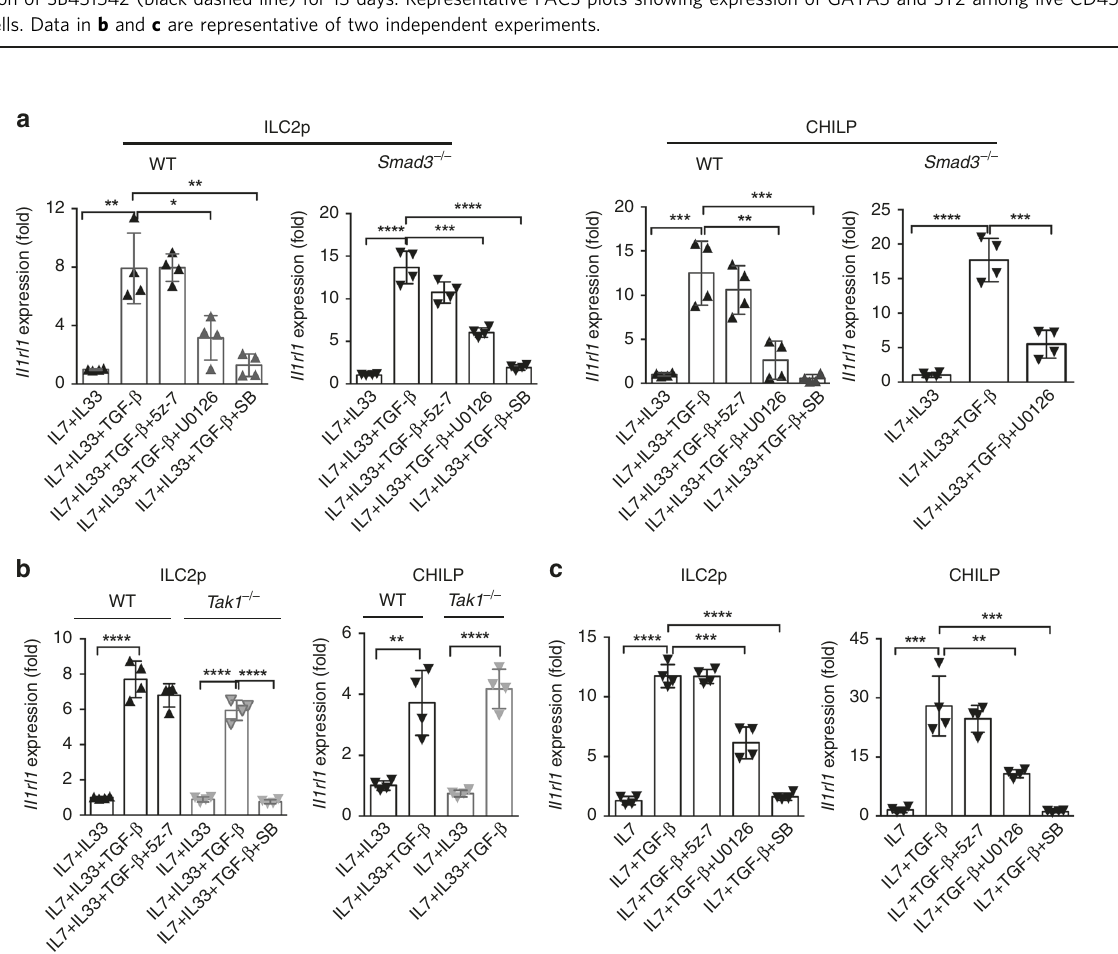
Fig. 4 TGF- β promotes in vitro development of ILC2 from BM precursors and upregulates ST2 expression. a WT or Tgfbr2 − / − CHILP cells (Lin − CD127 + Flt3 − α 4 β 7 + CD25 − ) were co-cultured with OP9-DL1 cells in presence of IL-7 (20 ng/ml) and IL-33 (20 ng/ml) or TGF- β (2 ng/ml) or T β R1 inhibitor SB431542 (5 μ M) for 13 days and analyzed using fl ow cytometry. Left panel: representative FACS plots depict frequency of ILC2 cells generated from WT and Tgfbr2 − / − CHILP, respectively. Middle two panels: histograms show representative expression of GATA3 and ST2 in WT and Tgfbr2 − / − LC2 cells. Numbers indicate mean fl uorescence intensity (MFI). Right upper panel is showing frequency of both Lin − CD127 + GATA3 + ST2 + and Lin − CD127 + GATA3 + ST2 − among CD45 + live cells in CHILP cultures (day 13) of WT and Tgfbr2 − / − cells. Right lower panel is showing total numbers of both Lin − CD127 + GATA3 + ST2 + and Lin − CD127 + GATA3 + ST2 − among CD45 + live cells in CHILP cultures (day 13) of WT and Tgfbr2 − / − cells. Data shown are pooled of three ( Tgfbr2 − / − CHILP) and fi ve (WT CHILP) independent experiments. Statistical analysis was performed using one-way ANOVA followed by Tukey ’ s multiple comparison test (* p < 0.05; ** p < 0.01). b WT ILC2 precursors (ILC2p; Lin − CD127 + Flt3 − α 4 β 7 + CD25 + ) cultured with OP9-DL1 stromal cells with IL-7 and IL-33, in the presence (black solid line) or absence (gray solid line) of TGF- β 1, and analyzed for CD127 + GATA3 + ILC2s on day 13 of culture, pre-gated with live CD45.2 + Lin − cells. The above numbers indicate the frequency and the numbers below indicate the events number of the indicated gate, respectively. The expression levels of GATA3 and ST2 in these cultured ILC2s were assessed. c Representative FACS plots of sorted WT ILC2p cells co-cultured with OP9-DL1 stromal cells plus IL-7 and IL-33, in the presence (black solid line) or absence (gray solid line) of exogenous TGF- β , or with addition of SB431542 (black dashed line) for 13 days. Representative FACS plots showing expression of GATA3 and ST2 among live CD45 + Lin −